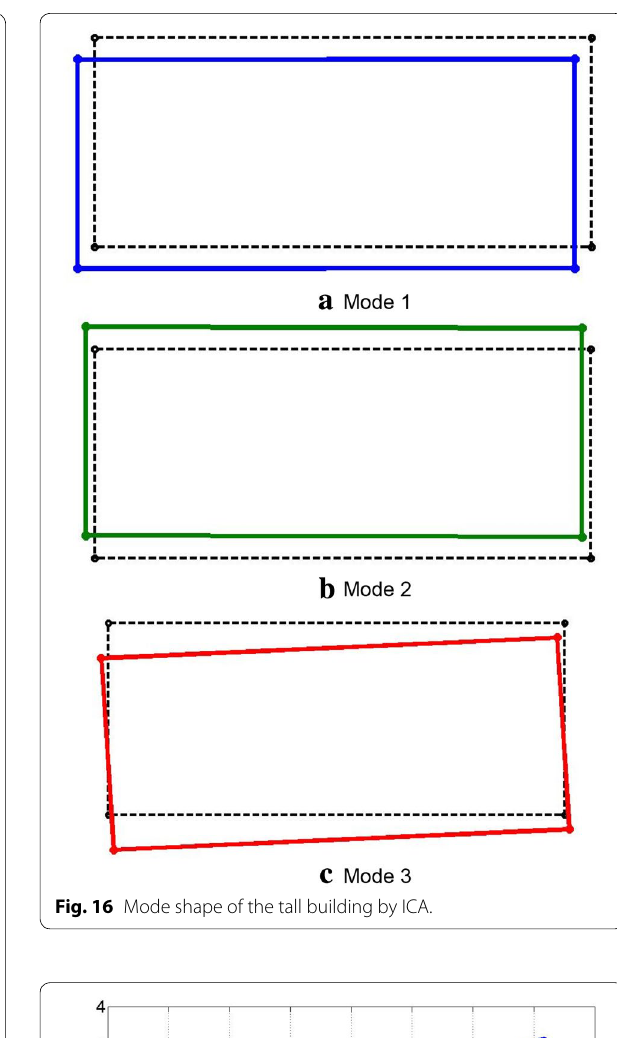
Fig. 16 Mode shape of the tall building by ICA.